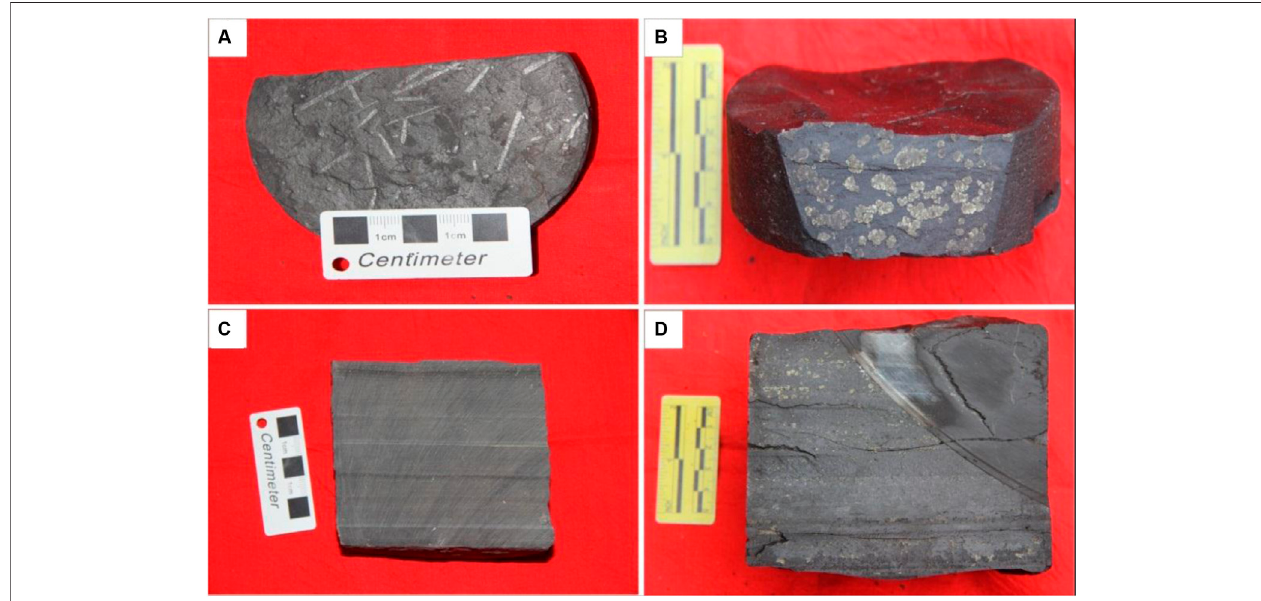
FIGURE 3 | The features of the Wulalike shale. (A) The shale with graptolite fossils, 4,755.2 m. (B) Many pyrites can be seen in the shale, 4,758.4 m. (C) The horizontal bedding in the shale core, 4,730.5 m. (D) The fractures are developed in shale, 4,735.6 m.